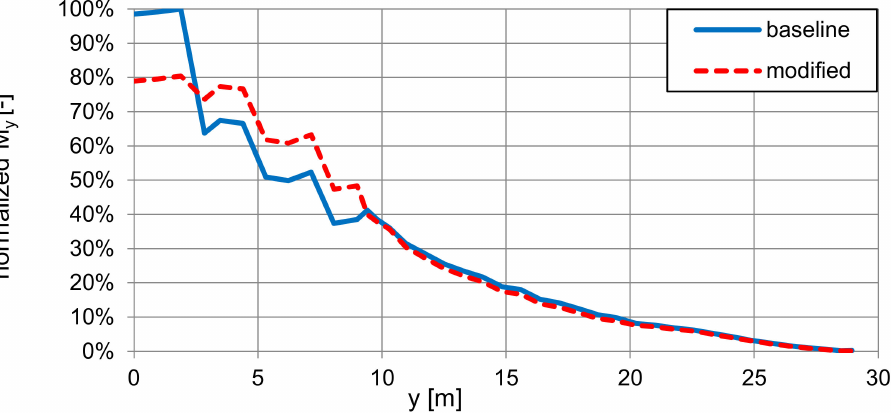
Figure 12. Normalized maximum torsional moment (M y ) over the span, comparison of the two